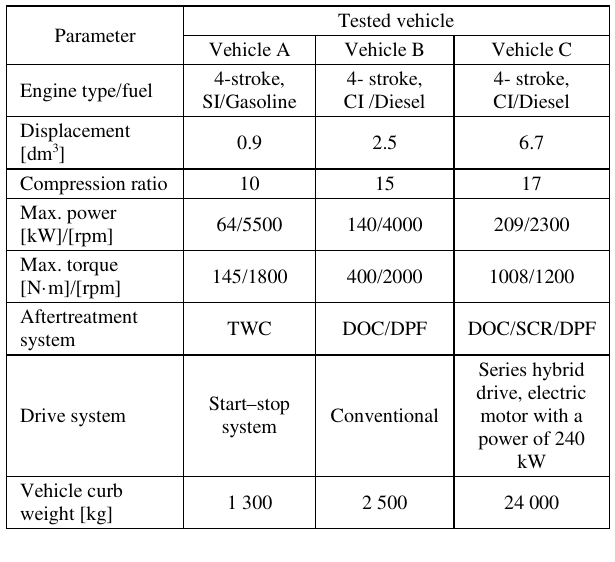
Table 1. Vehicle technical